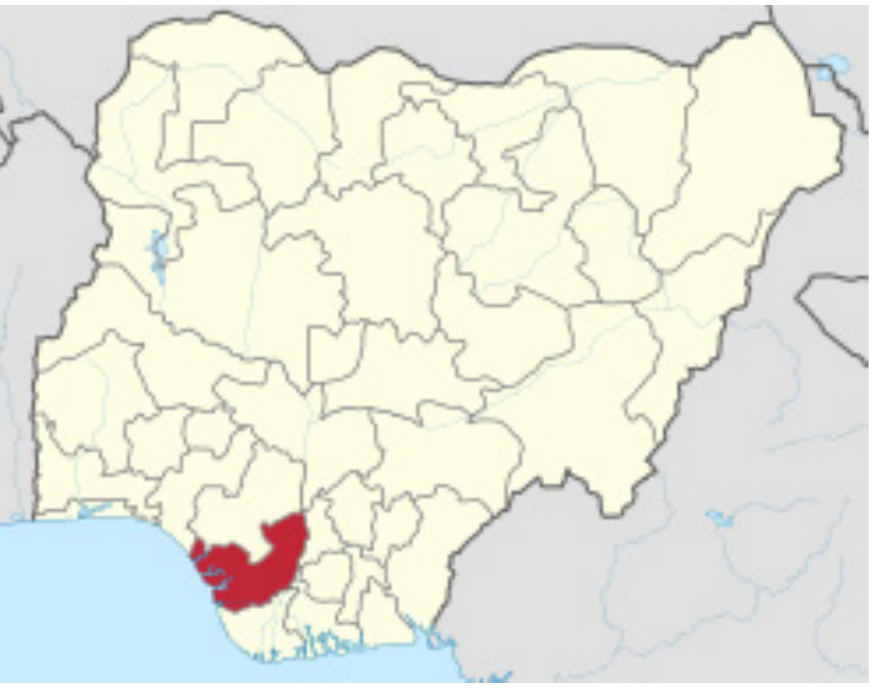
Figure 1: Location of Delta State in Nigeria; Source: Wikipedia, 2017 (https://en.wikipedia.org/wiki/Delta_State)